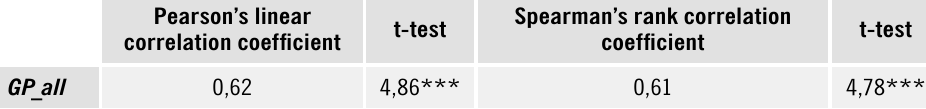
Table 1. Values of correlation coefficients between OF and GP _ all Pearson’s linear correlation coefficient